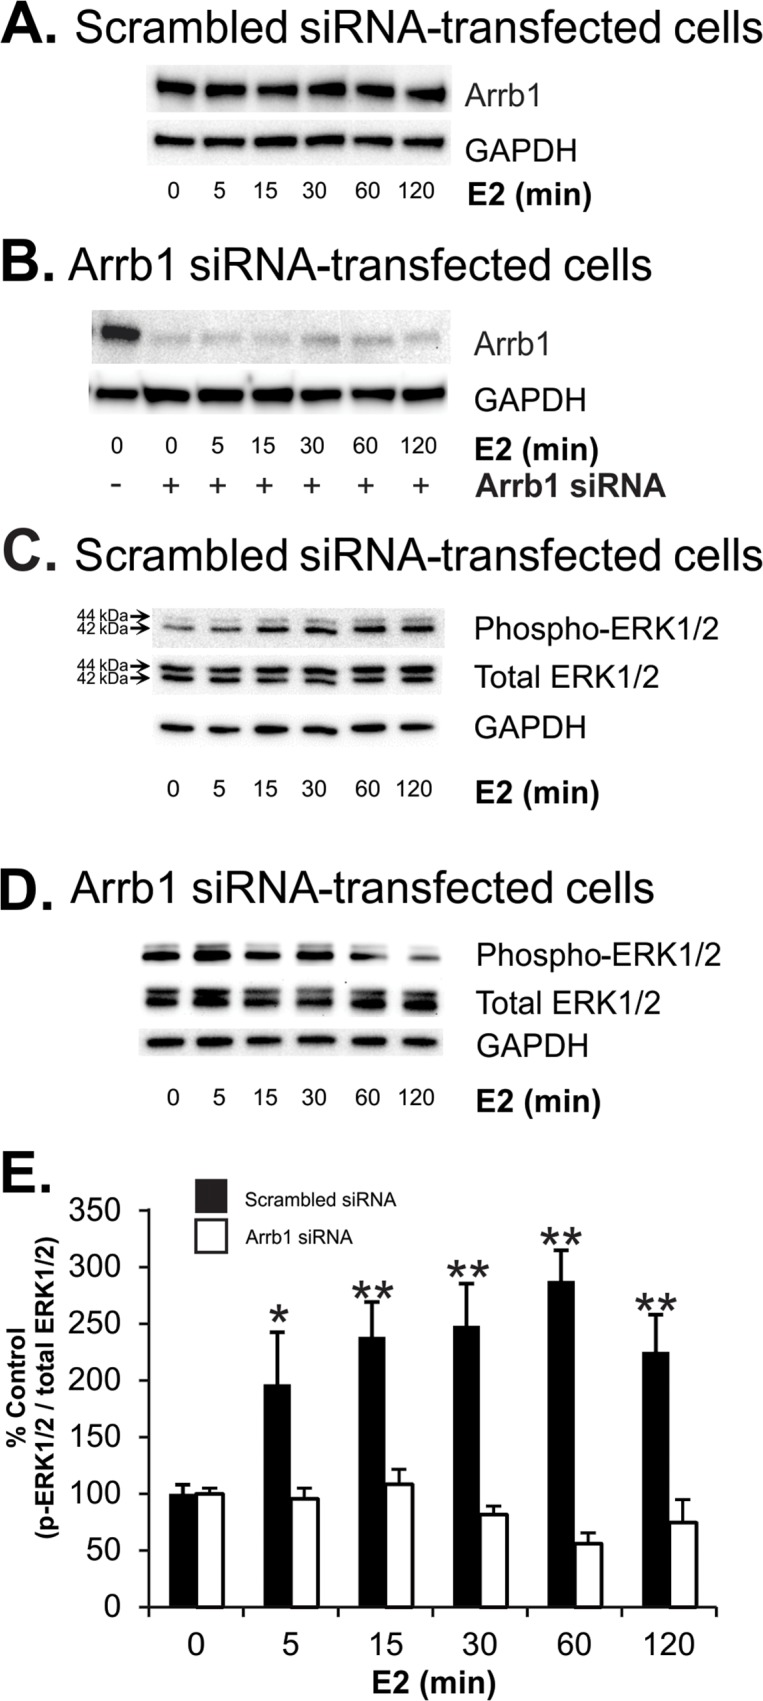
Estradiol (E2)-induced ERK1/2 phosphorylation in N-38 cells was attenuated in cells transfected with Arrb1 siRNA.(A) Western blots from scrambled siRNA-transfected N-38 cells probed with Arrb1 and GAPDH. (B) Arrb1 western blots from scrambled siRNA-transfected N-38 cells showing knockdown of Arrb1 protein. (C) Representative western blots of levels of ERK1/2 (p44/42 MAPK) phosphorylation in scrambled siRNA-transfected N-38 cells and (D) N-38 cells transfected with Arrb1 siRNA treated with estradiol (E2) for 0–120 min. (E) Densitometric analysis of the optical density from western blots of phosphorylated ERK1/2 (p44/42) protein bands normalized to the optical densities of total ERK1/2 protein in scrambled vs. Arrb1 siRNA-transfected cells. Controls for each group (cells not treated with E2) was set at 100%, and E2 treatments were expressed as a percentage of the control. Values represent means (n = 5) ± SEM. * (p<0.05). **(p<0.005).